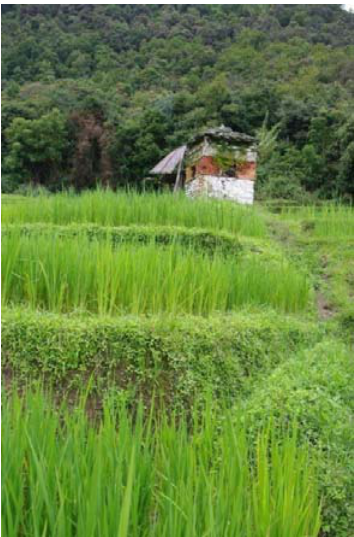
Figure 4. Trail with a Cholten near Thinlegang.